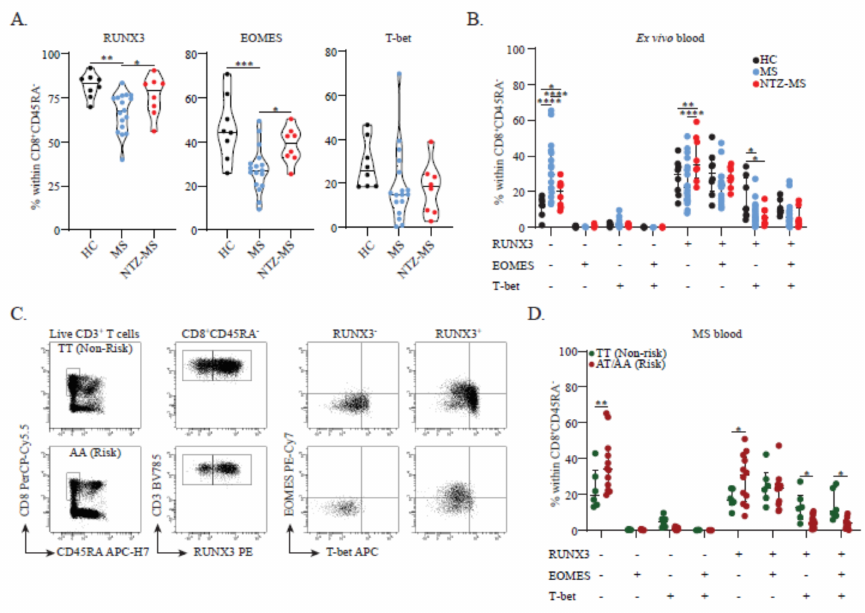
Figure 1. RUNX3, EOMES and T-bet expression patterns and the impact of rs6672420. ( A ) Expression of RUNX3, EOMES or T-bet expression in the CD8 + memory T cell pool (HC, n = 8; MS, n = 18; and NTZ-MS, n = 8). ( B ) Coexpression of RUNX3, EOMES and T-bet in the CD8 + memory T cell pool (HC, n = 8; MS, n = 18; and NTZ-MS, n = 8). ( C ) Representative FACS plot showing the distribution of CD8 + memory T cells (left), their RUNX3 expression (middle) and EOMES and T-bet coexpression (right) within a blood sample of a MS patient who was either homozygous non-risk (top, TT) or a risk carrier (bottom, AA) for rs6672420. ( D ) Coexpression of RUNX3, EOMES and T-bet in the peripheral blood CD8 + memory T cell pool of MS patients that did ( n = 12, n = 6 AT and AA) or did not ( n = 6, TT) carry the rs6672420 risk allele. Data were compared using a two-way ANOVA or ( B , D ) Kruskal–Wallis tests, both with FDR-BKY corrections. * p < 0.05, ** p < 0.01, *** p <